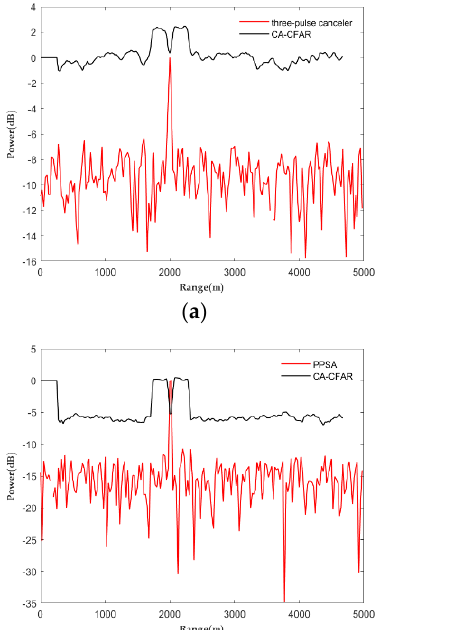
30.2008 Table 10. SCNR comparison of target 2.